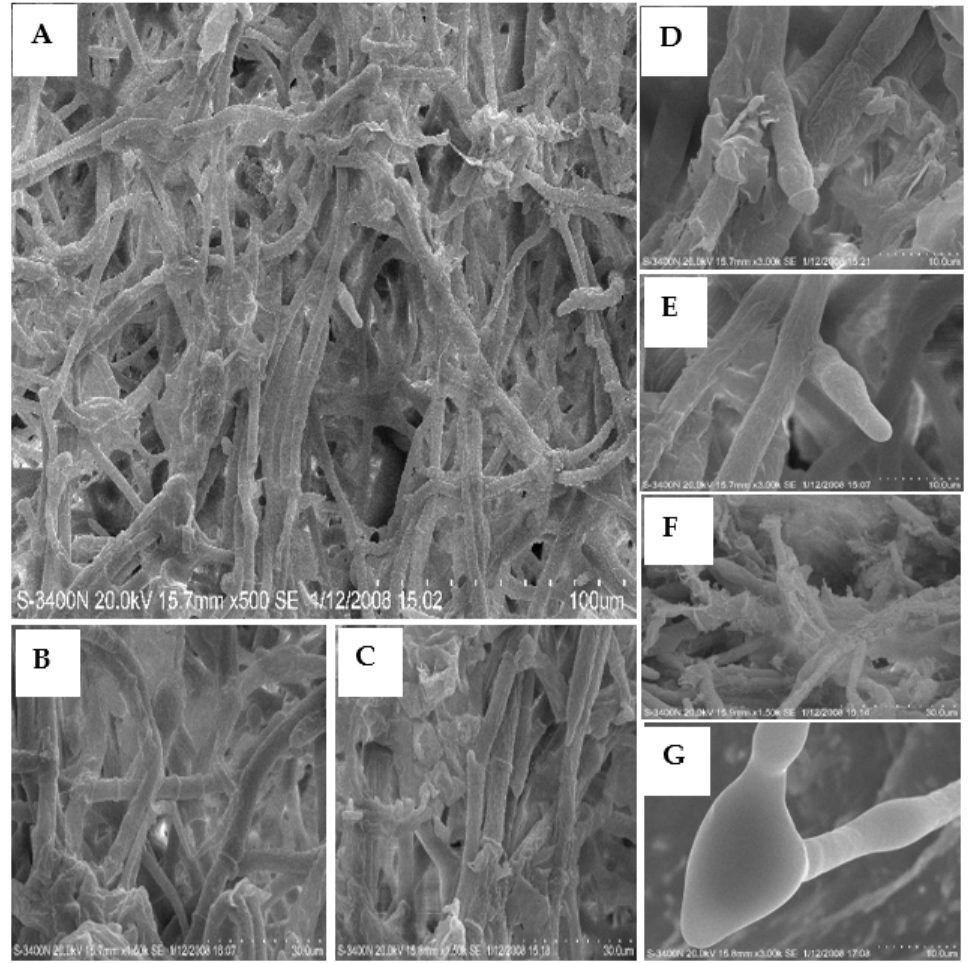
Figure 4. SEM images of the hyphae from the colony of B. cinerea grown on PDA medium with 100 μg/mL of L13 . The mycelium swelled, parts of mycelia ruptured and formed abnormal configura- tions on the mycelium tip. Scale bars: ( A ) 100.0 μm; ( B , C , F ) 30.0 μm; ( D , E , G ) 10.0 μm.